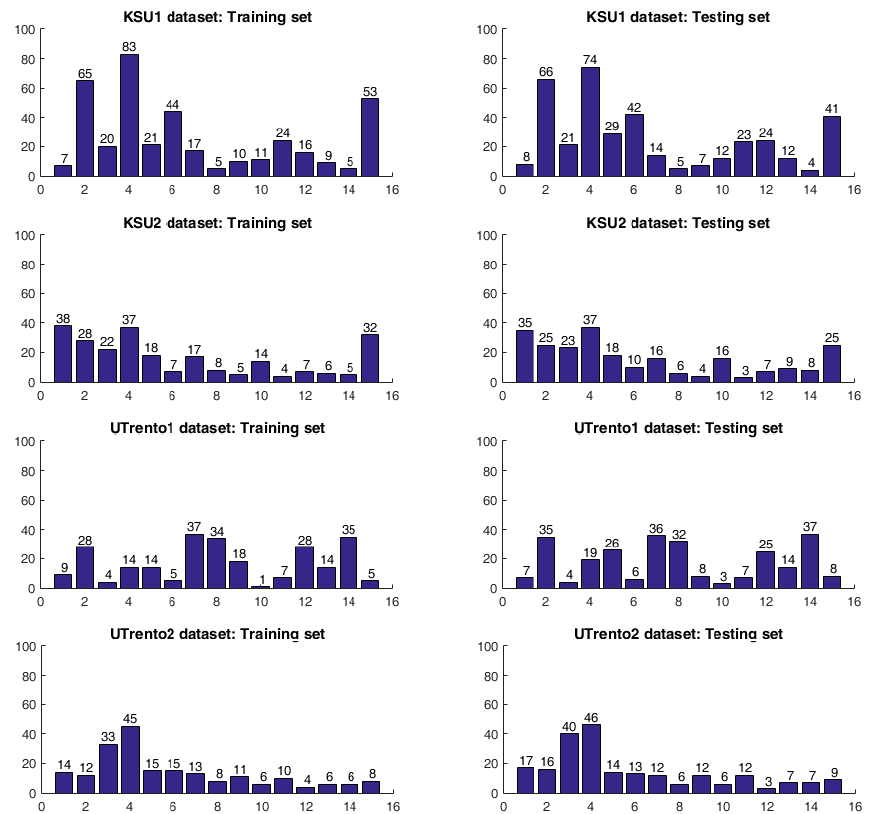
Figure 10. Number of occurrences of objects in each dataset. The x axis represents the object number according to the list given in Table according to the list given in Table 1.